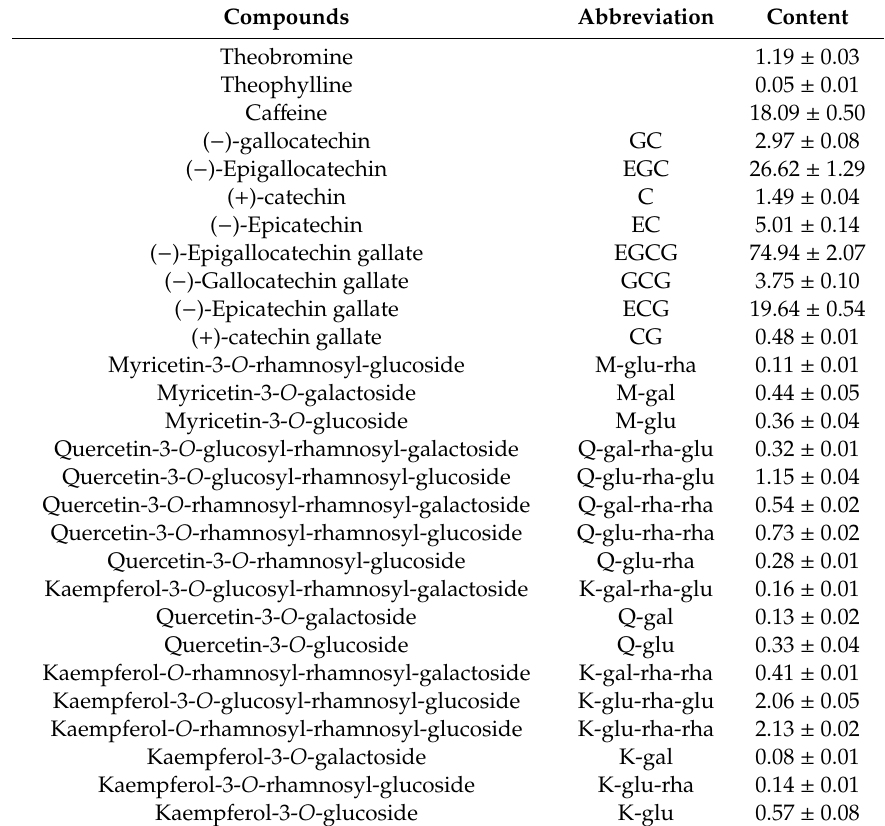
Table 4. The chemical composition of tea leaves (mg /